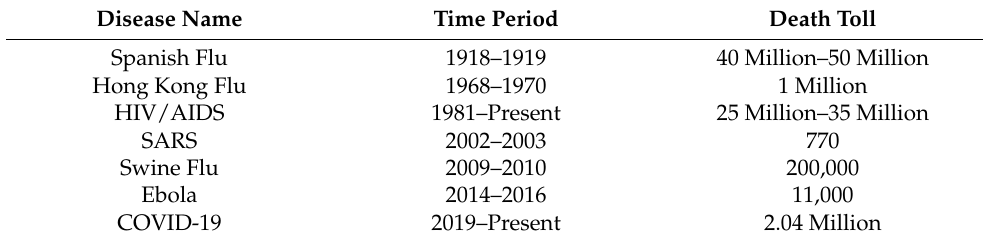
Table 1. The history of pandemics with respect to the death